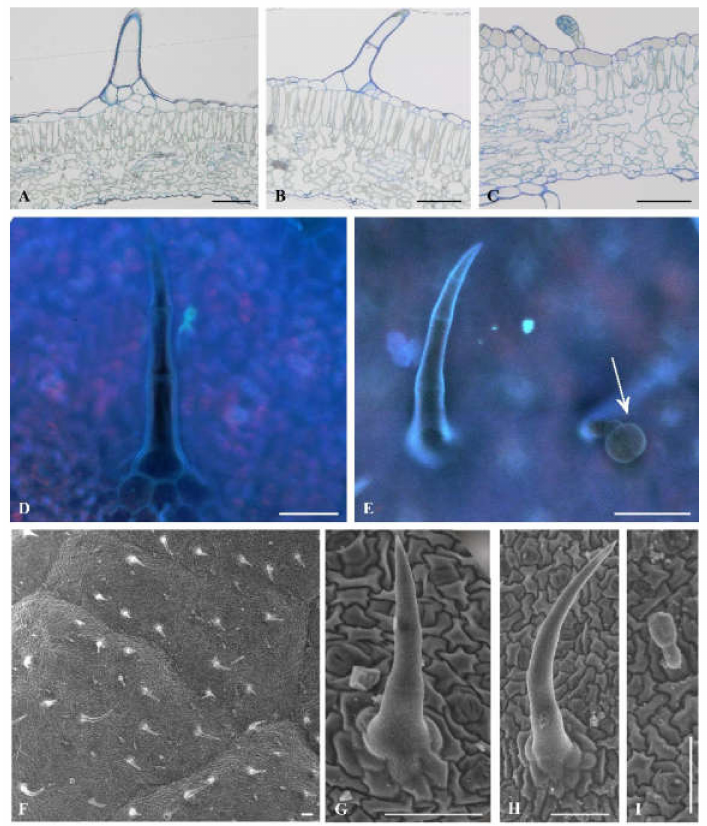
Figure 3. Trichome types on the Bryza adaxial leaf surface. Light microscopy views of leaf cross-sections ( A – C ). Epifluorescence ( D , E ) and SEM imaging: surface ( F ), trichomes ( G − I ). Non-glandular types: group II A , D , G , group V: B , E , H , glandular type VII present on C , arrow at E and I . All scale bars represent 100 µ